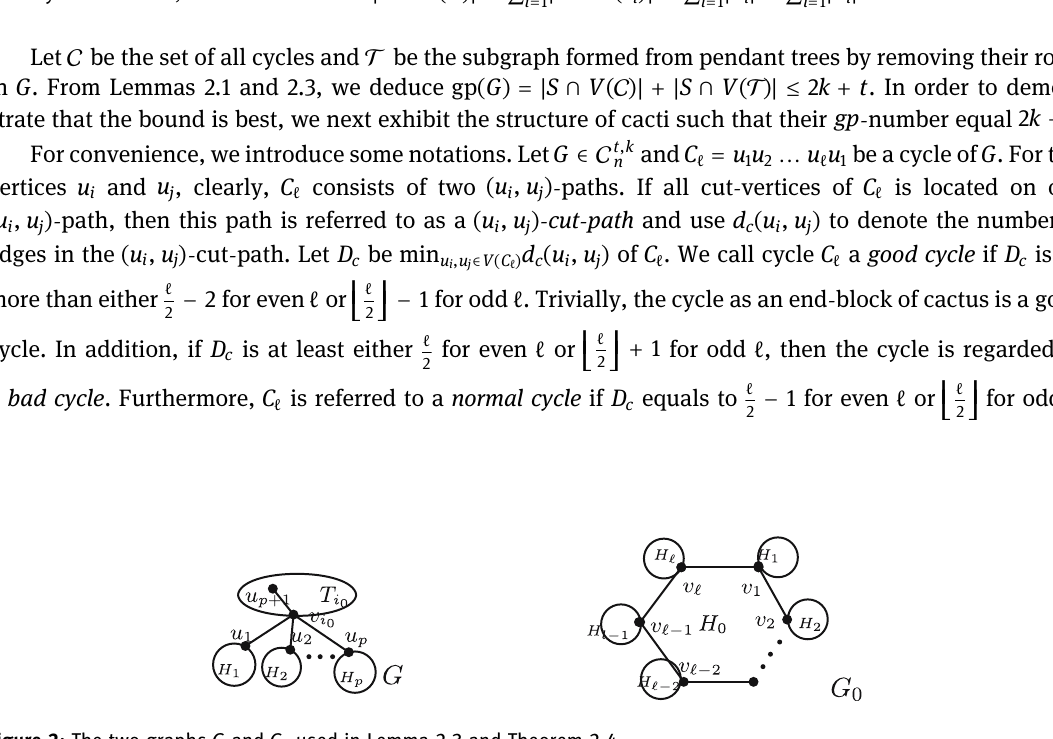
Figure 2: The two graphs G and G 0 used in Lemma 2.3 and Theorem